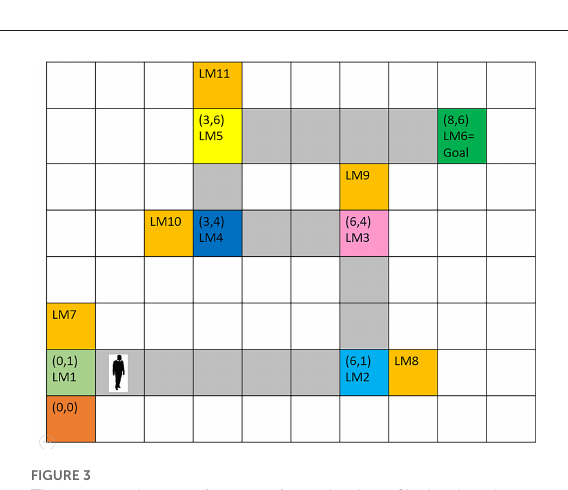
FIGURE3 The assumed route for agent’s navigation. Six landmarks are considered from the origin to the destination. It is assumed that at each landmark position, the next landmark is visible and that the landmark positions are the turning points of the route. Numbers in parentheses indicate coordinates with reference to the start point. Gray-colored squares between landmarks depict the correct path. Orange-colored squares indicate wrong paths, which the agent will enter by mistake, in case of low attention to turning points